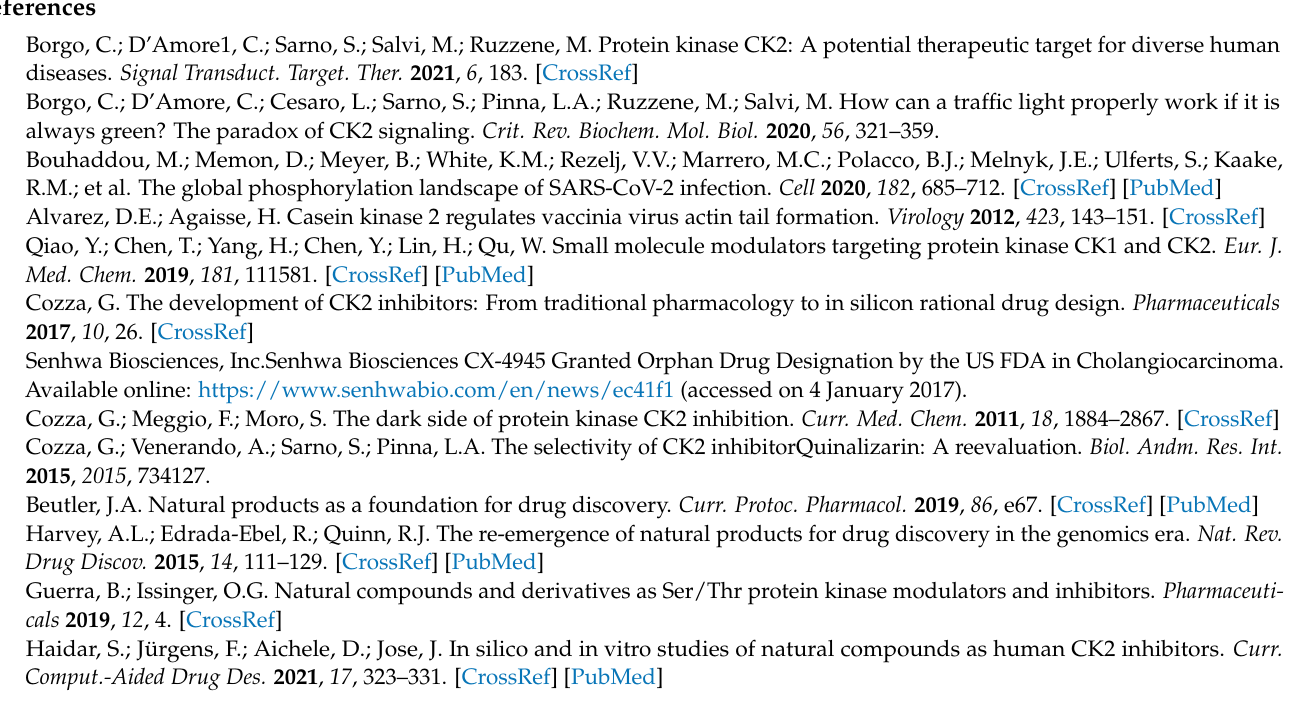
Figure S1: Scatter plots of molecular properties in different